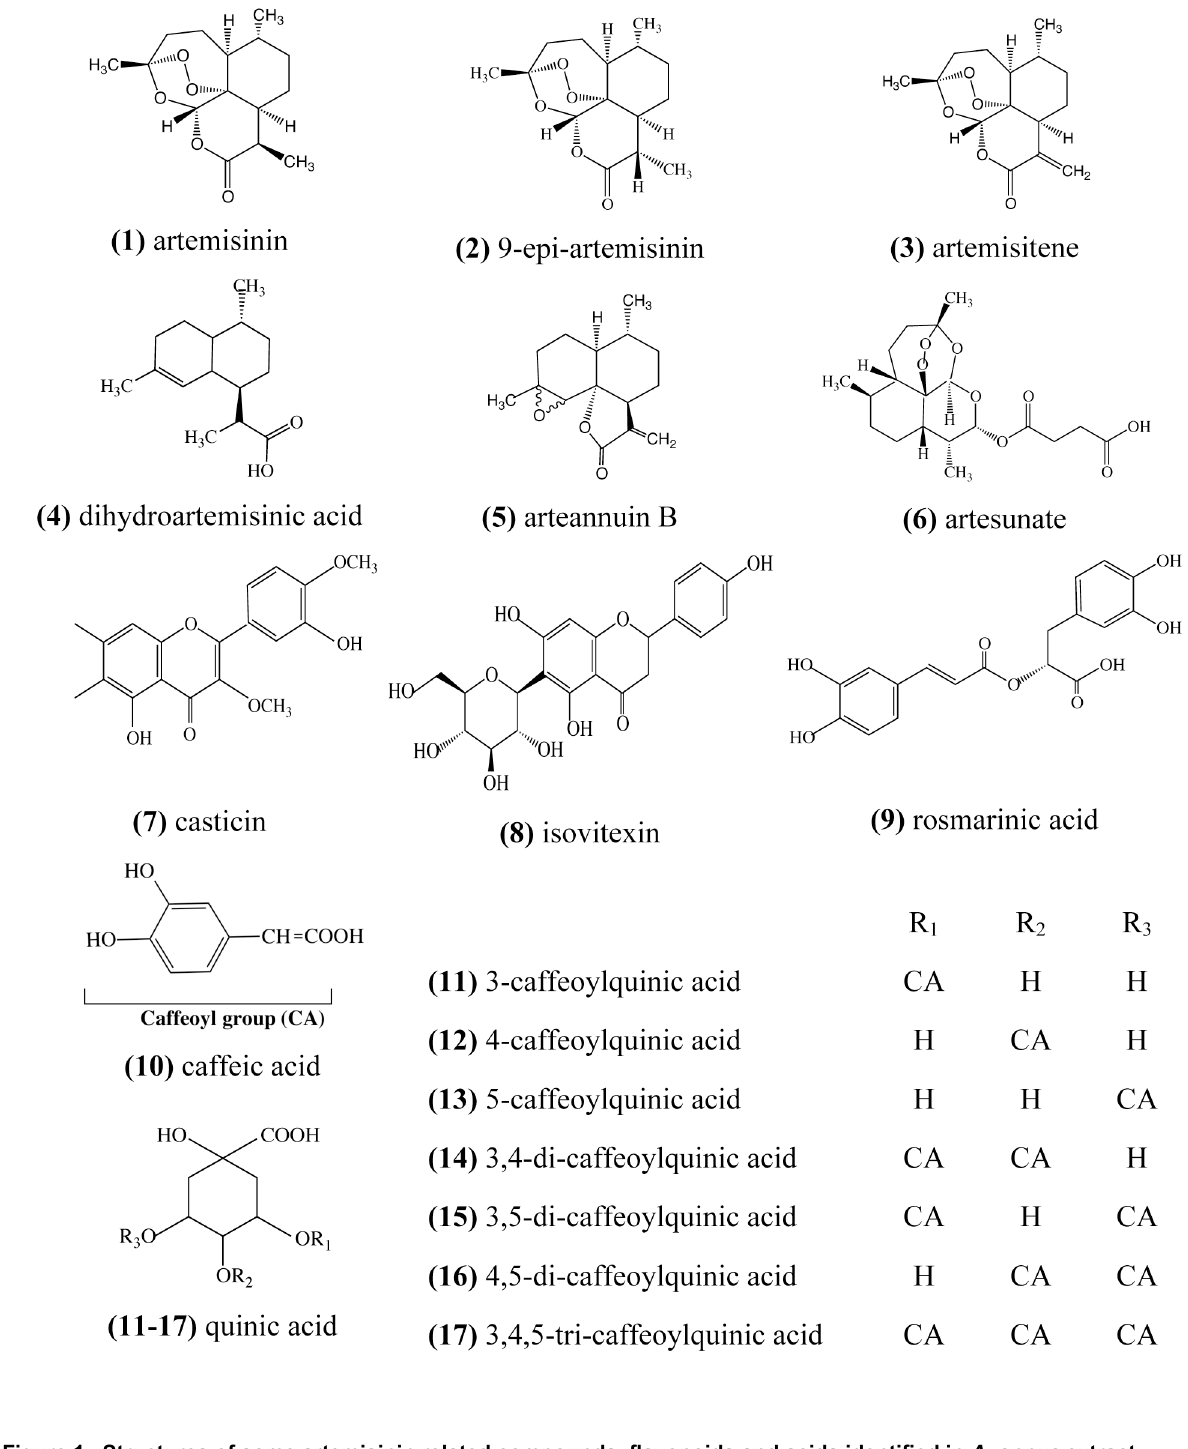
Figure 1. Structures of some artemisinin related compounds, flavonoids and acids identified in A. annua extract.